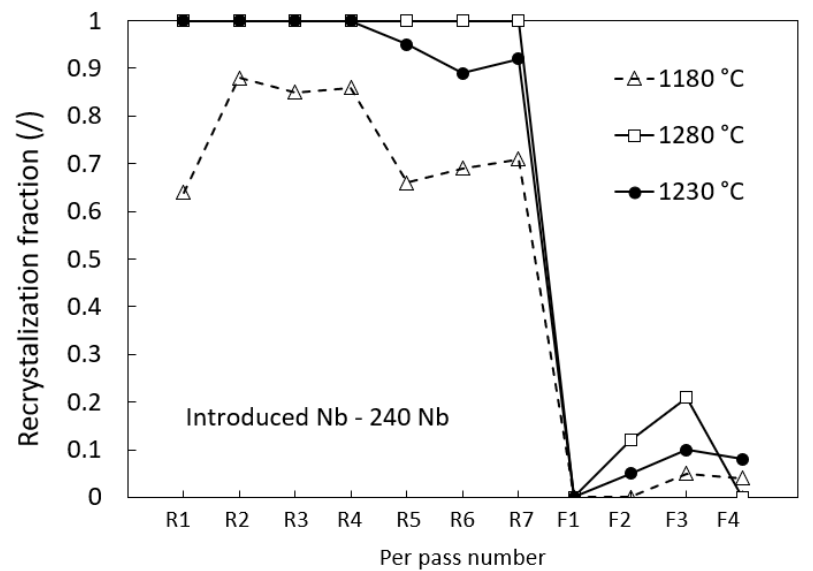
Figure 1. SRS prediction: Influence of predicted slab reheating temperature and SRX development as a measure for velocity of grain boundary movement during the equal interpass in the case of sample 240 Nb between 1180 and 1280 °C. The temperature drops, present during industrial rolling from the furnace to R1, were also considered.